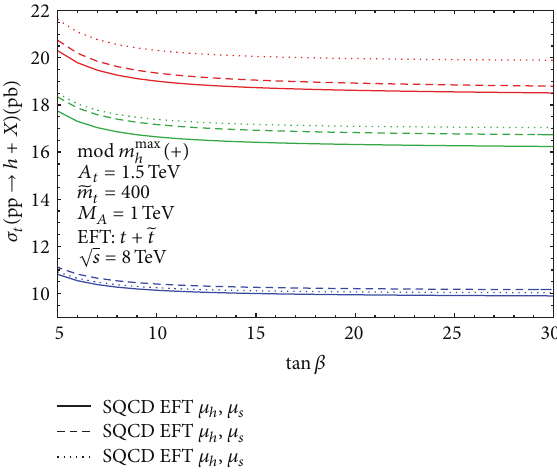
Figure 22: The cross section 𝜎 SUSY-QCD 𝑡 ( 𝜇 𝑠 , 𝜇 ℎ ) as a function of tan 𝛽 using the parameters in to LO (bottom), NLO (middle), and NNLO (top) from [54]. The dotted line corresponds to the SM and the dashed and solid lines to the